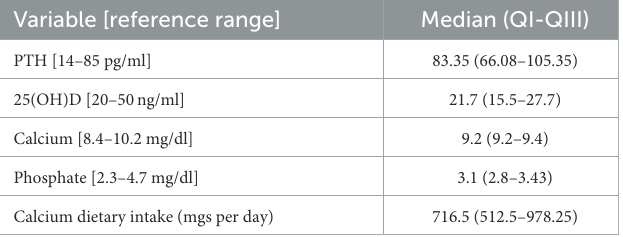
TABLE 1 Serum PTH, vitamin D, and related metabolites in our PD